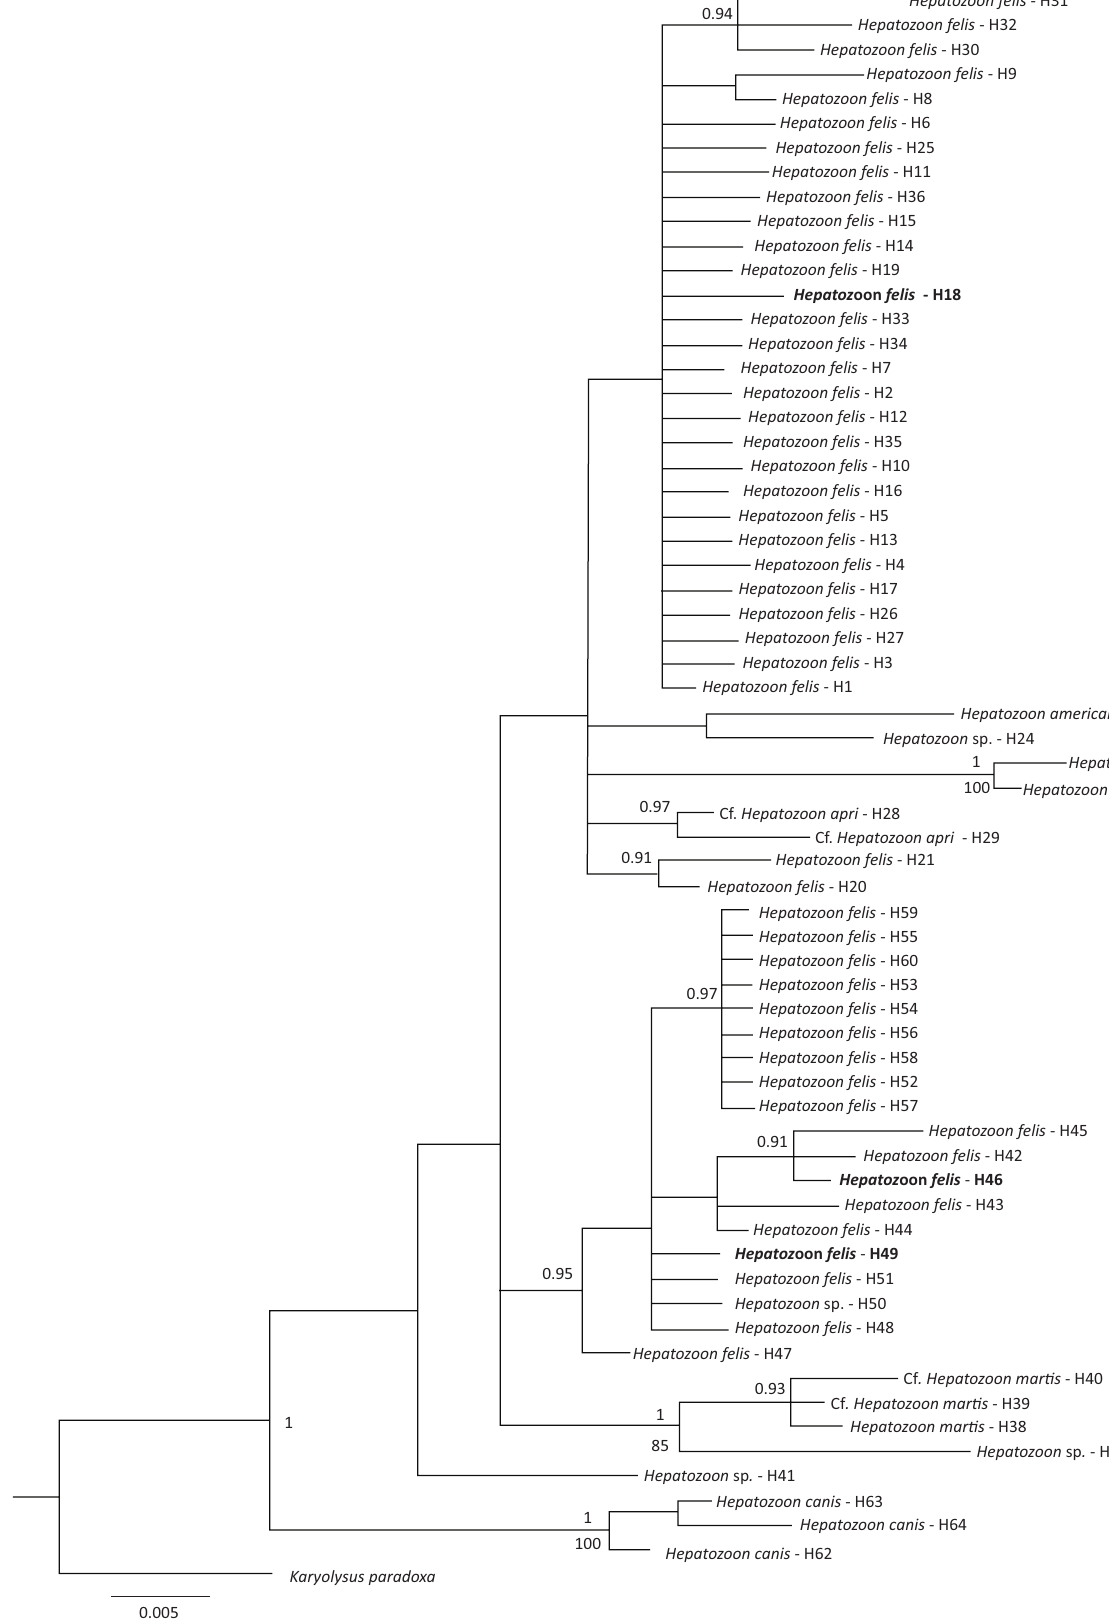
FIGURE 1: Estimate of relationships derived from a Bayesian inference analysis. Sequences derived for this study are in bold. Codes (H1-H64) refer to Supplementary material for GenBank numbers and additional details. The same code numbers are used in Figure 2. Posterior probabilities (> 0.9) and ML bootstrap support (> 85 % ) are indicated above and below nodes, respectively. The tree was rooted using Karyolysus paradoxa